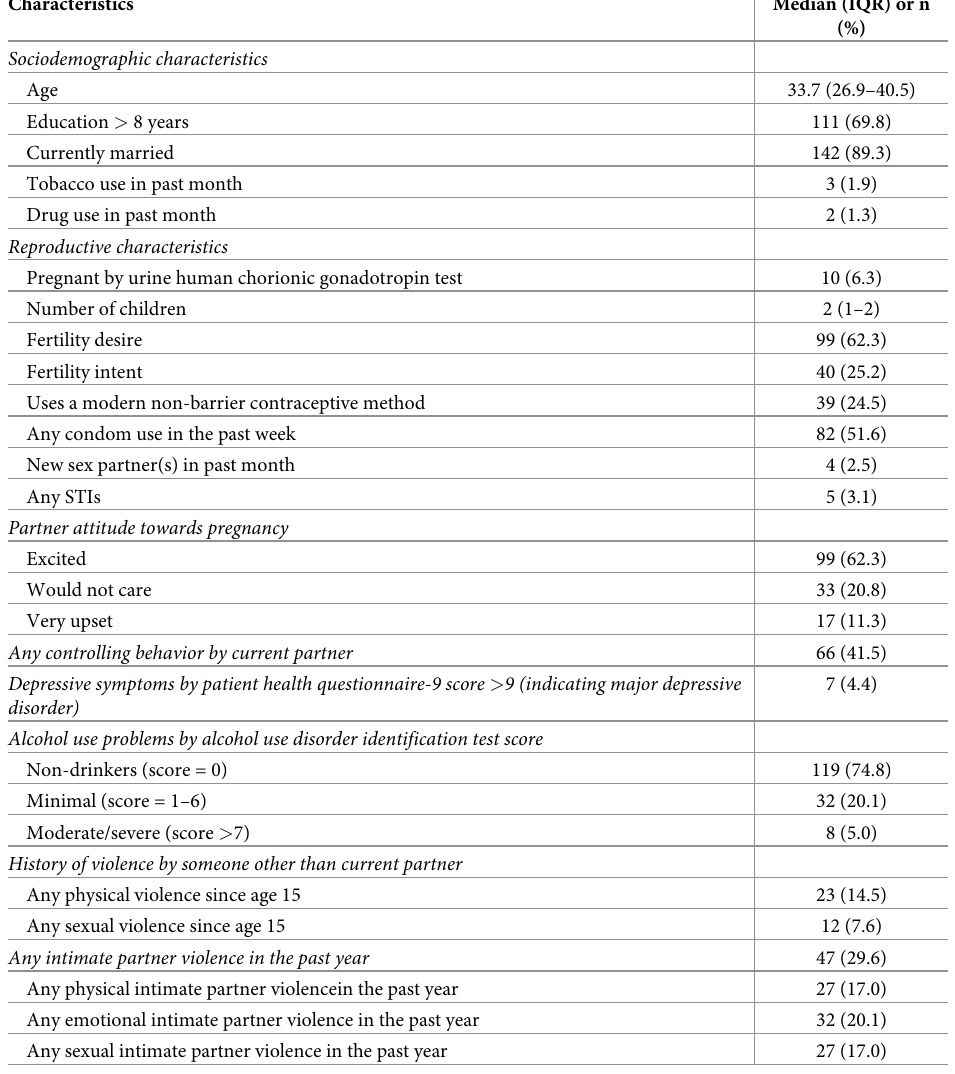
Table 1. Baseline characteristic of the study sample (N =